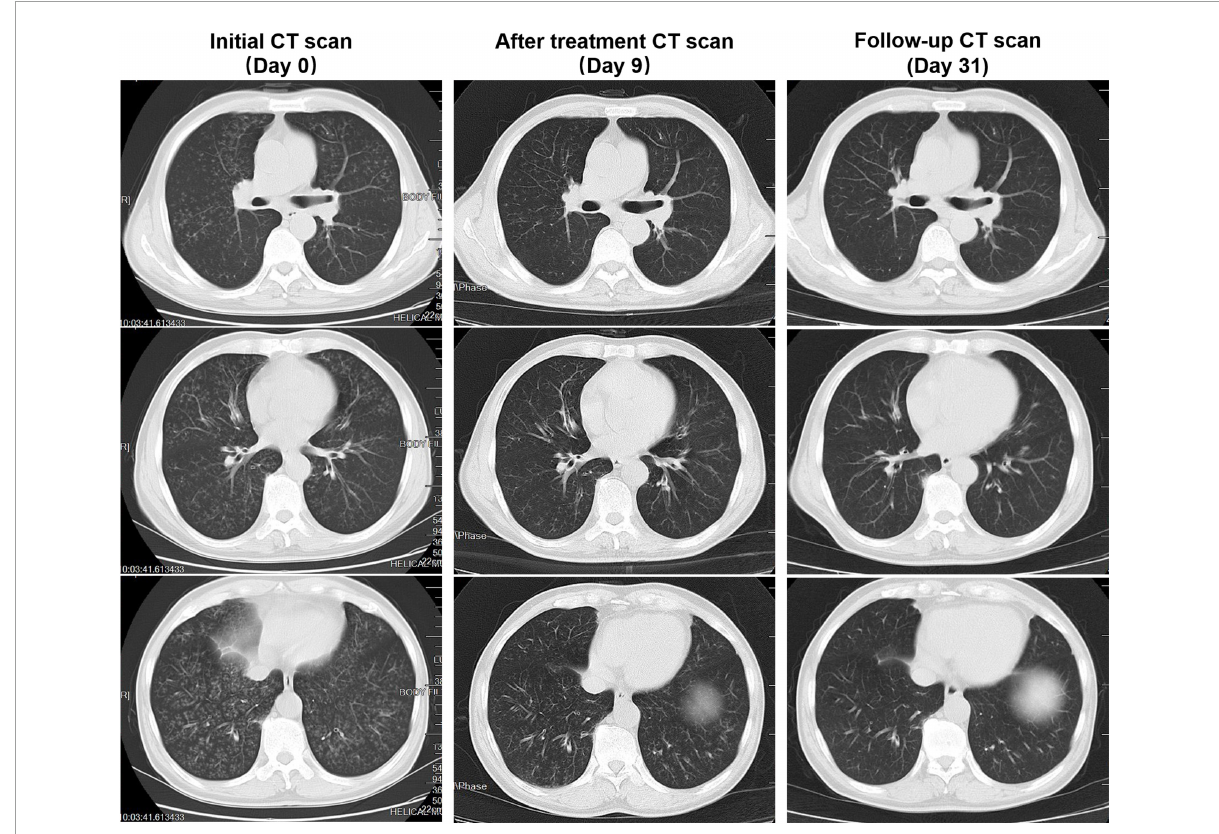
FIGURE1 Patient’s computed tomography (CT) scan images at three time points. Initial CT scan (Day 0) showed that bilateral diffuse nodules separated by the fissures and pleura. Some of the nodules have a “tree-in-bud” appearance. After treatment, CT scan (Day 9) showed visible absorption of diffuse nodules in both lungs. Follow-up CT scan (Day 31) showed that the bilateral diffuse nodules absorbed completely.